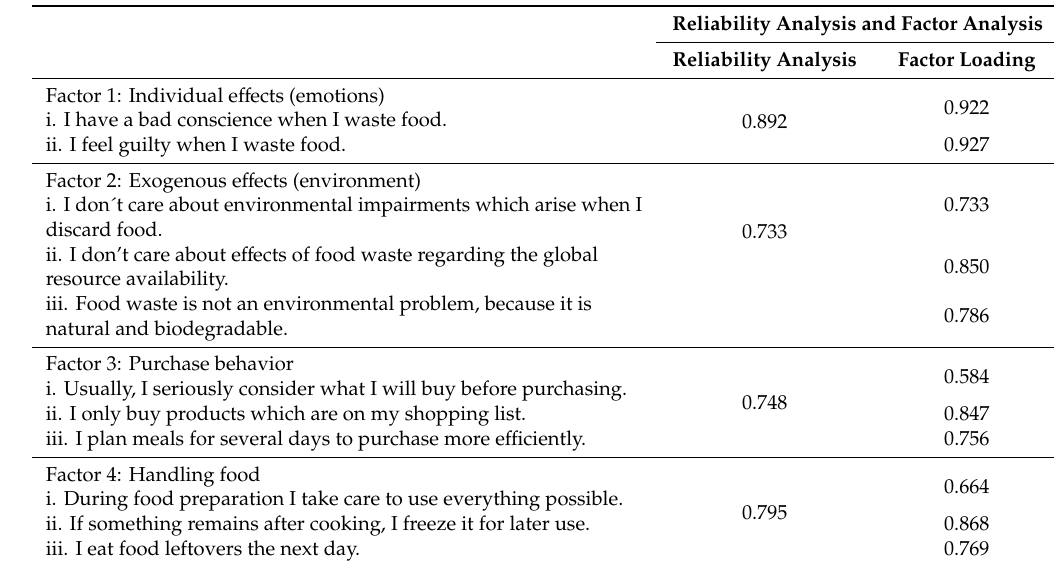
Table 2. Results of the reliability and factor analyses.